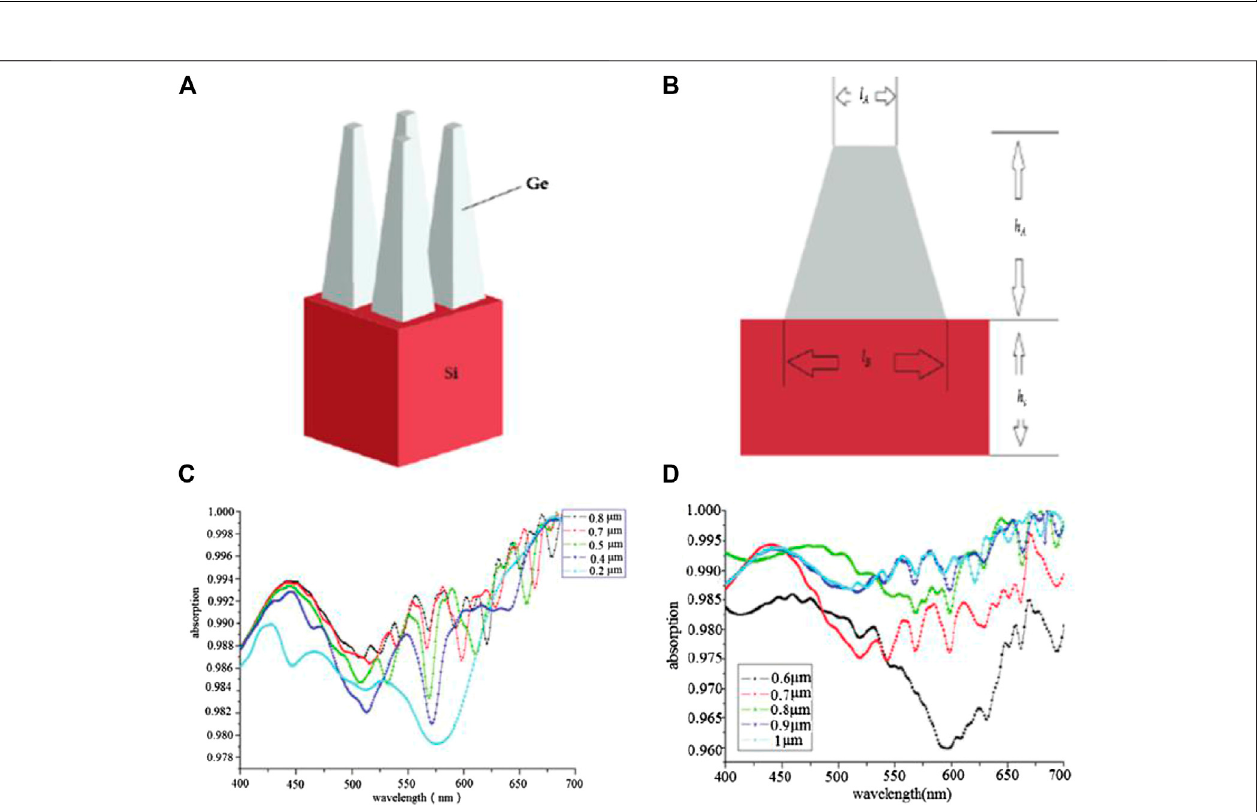
FIGURE7|(A) Three-dimensional structure; (B) side view (C) Curve ofabsorbancewithunderlayment thickness, (D) Thein fl uence oftheheight ofthequadrangle on the absorptivity. Source : Reproduced from Ref. 30.